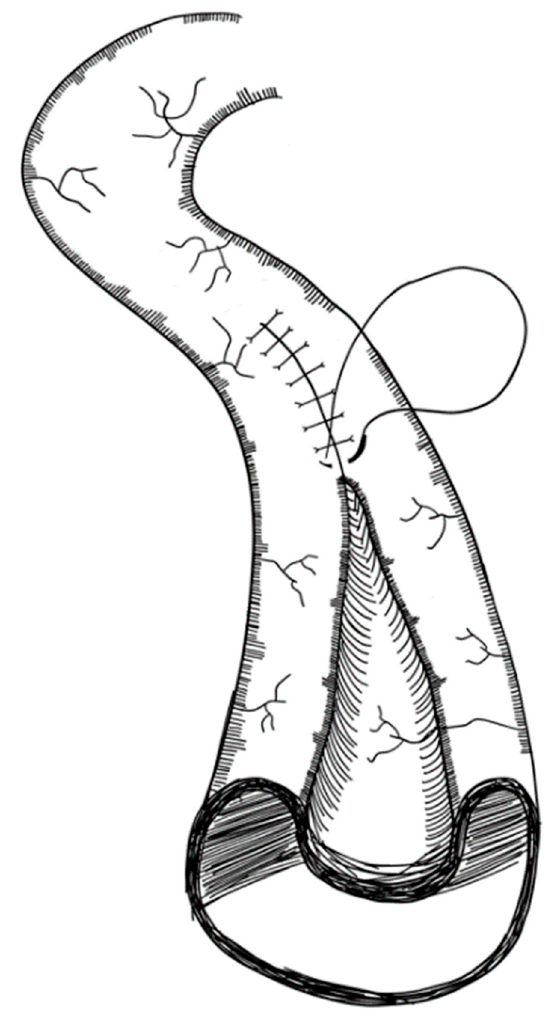
Figure 15. Plication of small intestine. de Lorimier and Harrison [176].